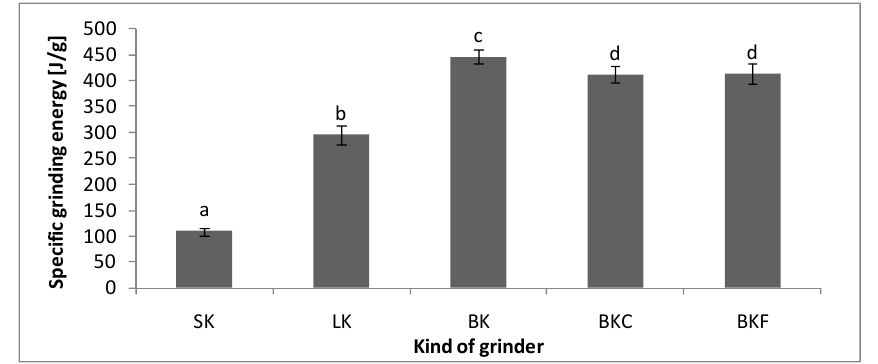
Figure 2. Specific grinding energy of flaxseeds. SK—short-knife grinding (20 s), LK—long-knife grinding (80 s), BK—short-knife grinding (20 s) and ball milling (60 s), BKC—short-knife grinding (20 s) with ball milling (60 s) of coarse fraction, BKF—short-knife grinding (20 s) with ball milling (60 s) of fine fraction.a,b,…—means with different letters are significantly different ( α < 0.05). Table 1. Particle size distribution of ground flax seeds.